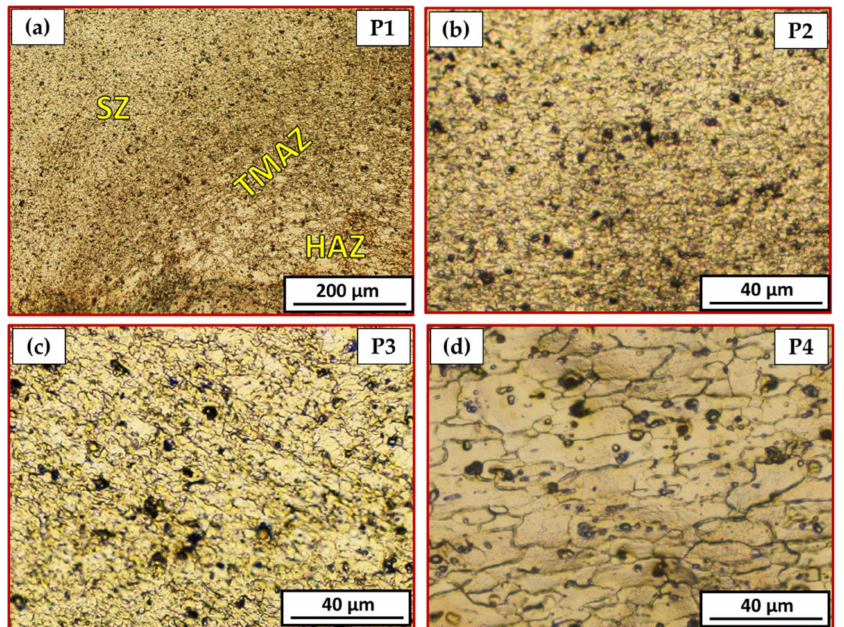
Figure 13. Different microstructure zones of the joint spot welded at 800 rpm where P1 is mixed zone of SZ/TMAZ/HAZ in ( a ), P2 is SZ in ( b ), P3 is TMAZ in ( c ), and P4 is HAZ in ( d ).